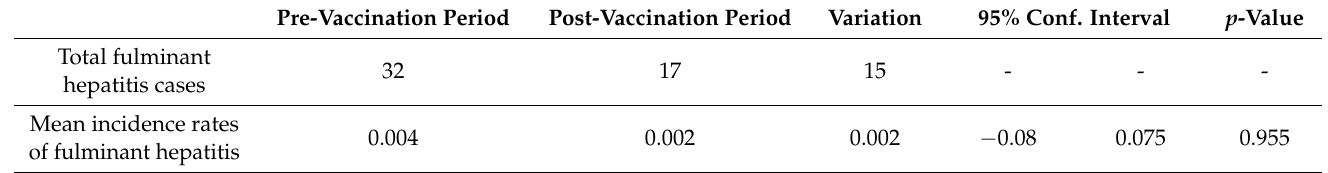
Table 5. Fulminant hepatitis number of cases and incidence during the period of the